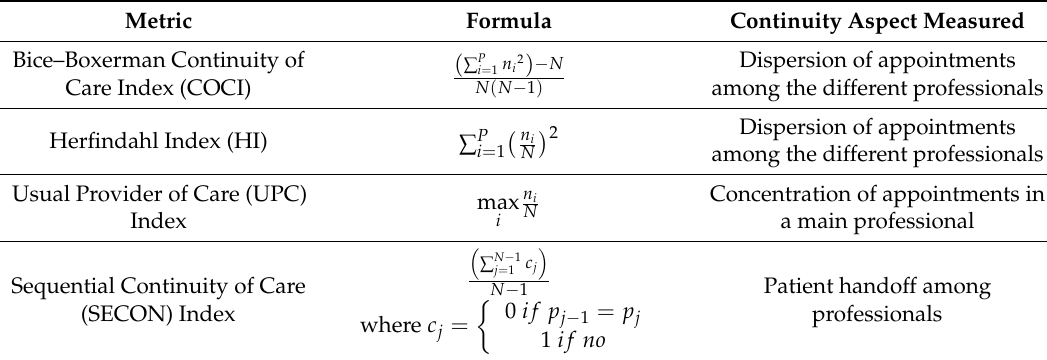
Table 1. Formulas for computing the continuity of care indices used in the